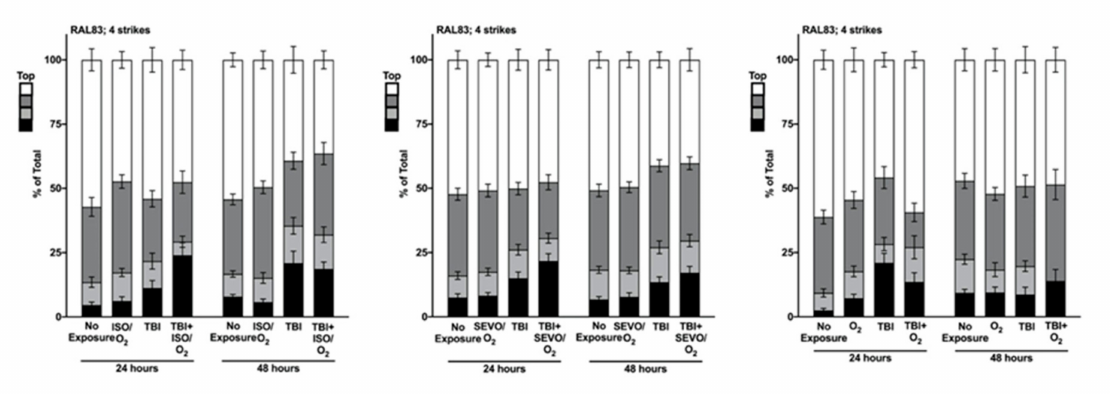
Figure A13. RAL83.